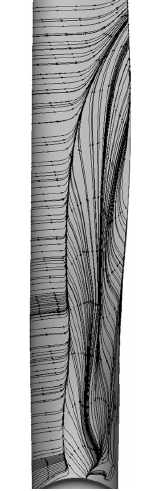
Figure 10. Blade root flow separation – suction side.